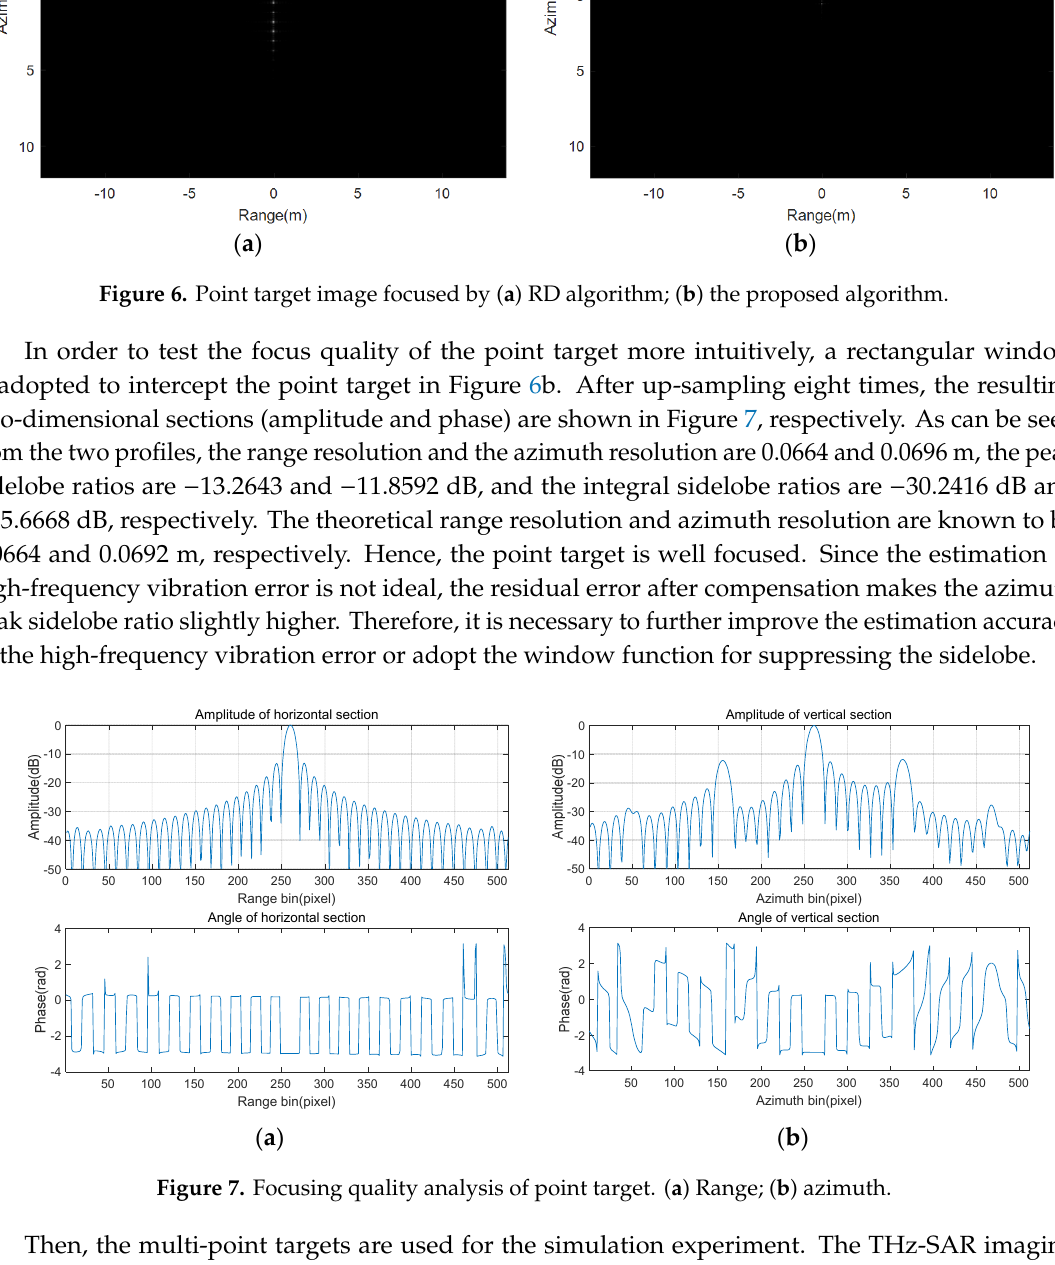
( b ) Figure 8. Imaging results of multi-point targets. ( a ) RD algorithm; ( b ) the propose algorithm. Finally, since there are no measured data of THz-SAR, the area targets are simulated to generate echo data in the experiment. The THz-SAR imaging results of the RD algorithm and the new proposed imaging algorithm in this paper are showed in Figure 9b,c, respectively. It can be seen that the new proposed imaging algorithm in this paper can effectively suppress paired echoes. However, the image quality after high-frequency vibration error compensation is slightly worse than the raw image shown in Figure 9a due to the residual error.